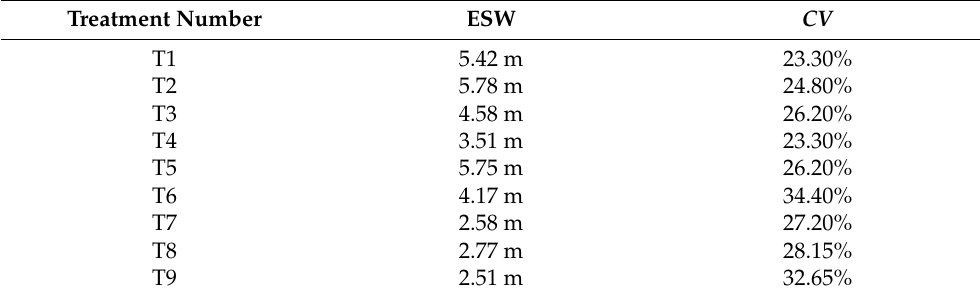
Table 5. Test result data of bandwidths, droplet deposition uniformities, and penetration rates.